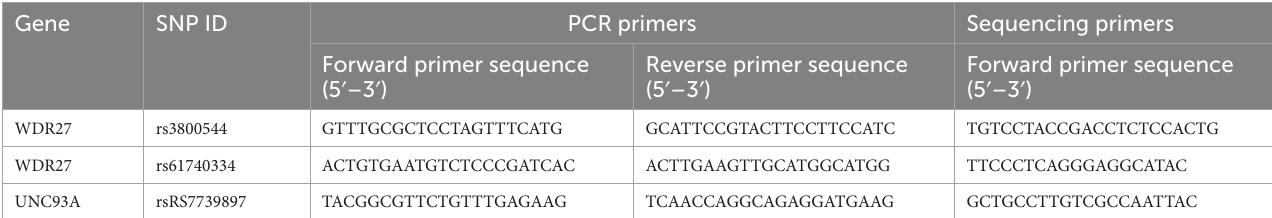
TABLE 1 Polymerase chain reaction and sequencing